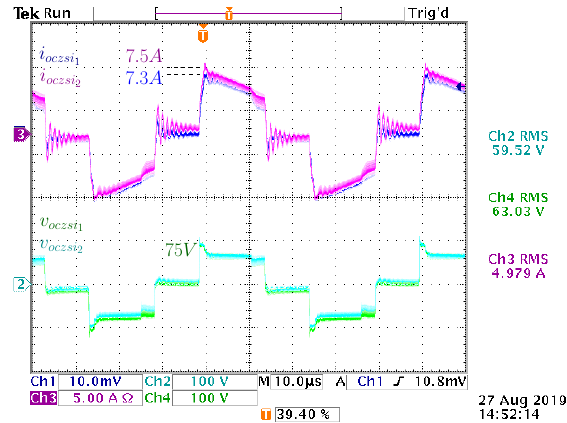
Figure 13. System test under balanced conditions. Ch1 (10 mV/div=5 A/div): i oczsi i oczsi , Ch2 (100 V/div): v oczsi 2